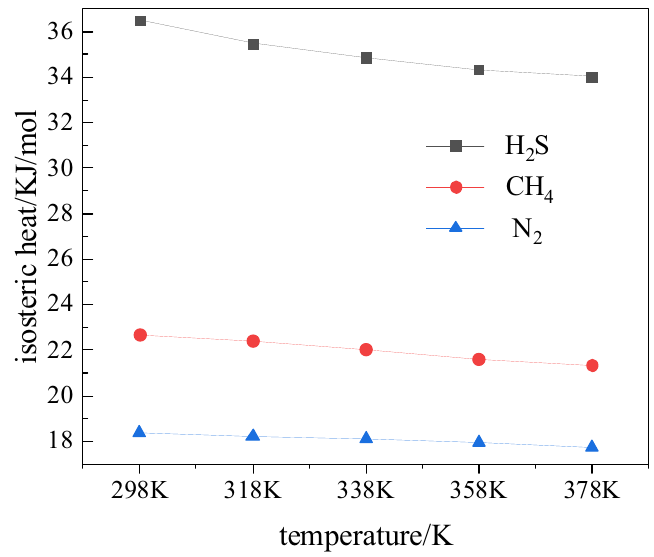
Figure 5. Adsorption heat of H 2 S, CH 4 and N 2 : Variation with temperature.